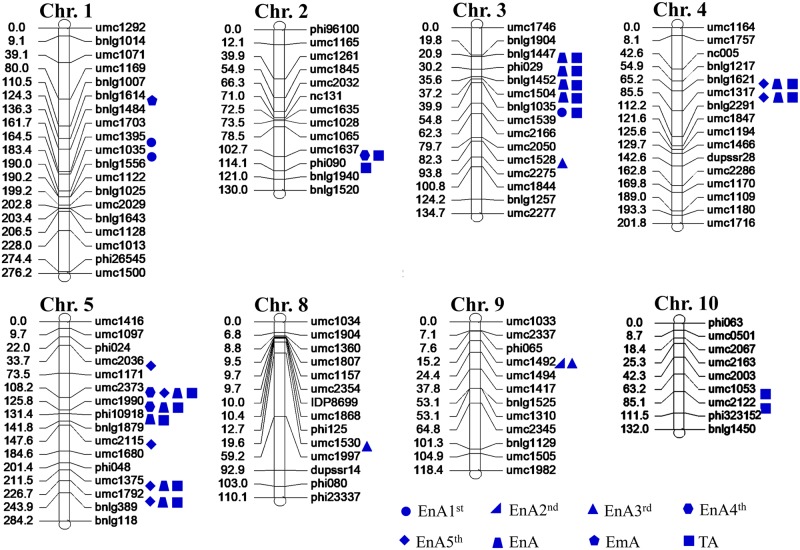
Distribution of QTL for kernel abortion related during parthenogenesis induced process in the first population (Zheng58×Chang7-2).The circle means QTLs for the 1st endosperm abortion kernels (EnA1st); the right triangle means QTLs for the 2nd endosperm aborted kernels (EnA2nd), the equilateral triangle means QTLs for the 3rd Endosperm aborted kernels (EnA3rd), the hexagon means QTLs for the 4th endosperm aborted kernels (EnA4th), The rhombus means QTLs for the 5th endosperm aborted kernels (EnA5th), the trapezoid means QTLs for the total endosperm aborted kernels (EnA). The pentagon means QTLs for the embryo abortion kernels (EmA). The square means QTLs for the total aborted kernels (TA).